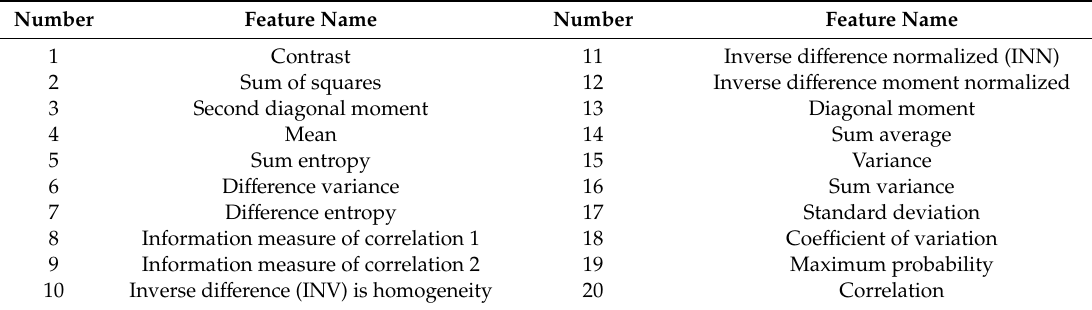
Table 2. Texture features extracted from the gray level co-occurrence matrix (GLCM)